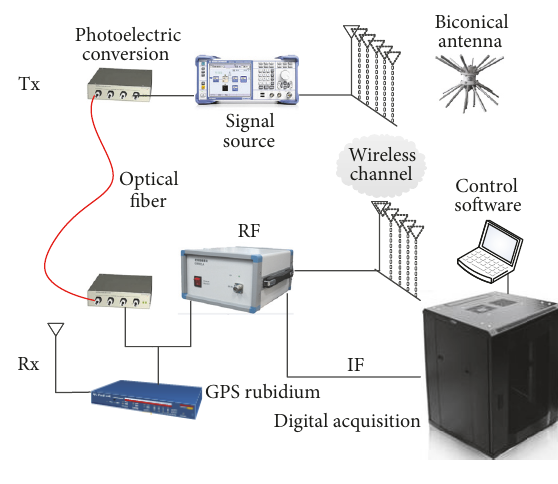
Figure 2: Measurement